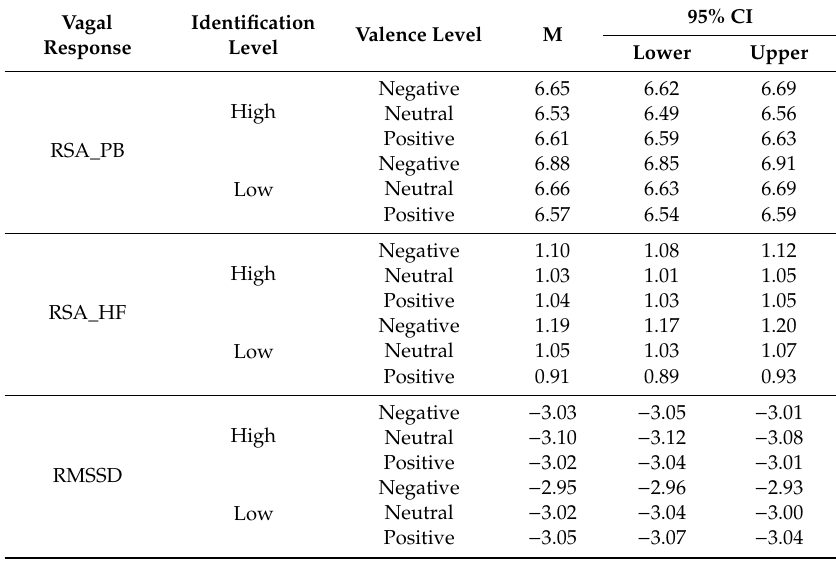
Table 8. Descriptive statistics of vagal response depending on identification level and valence. M = Mean, SD = Standard deviation. 95% CI = 95% of confidence interval.